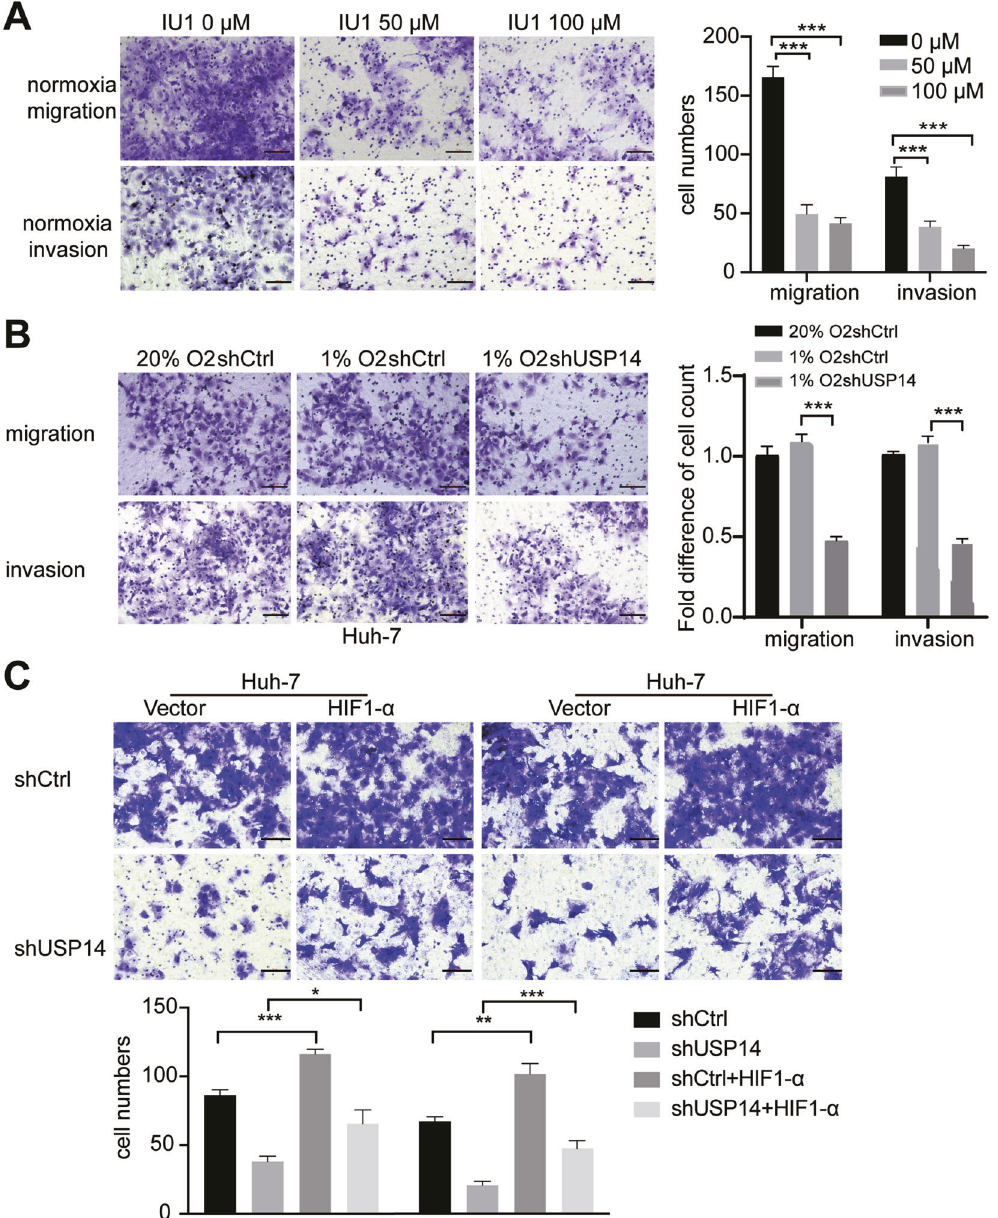
Fig. 5 USP14 promotes cell migration and invasion in HCC cells. A The migration and invasion ability of HCC cells were inhibited by 1U1 at a dose-dependent manner under normoxic conditions. Scale bar, 100 μ M. Quanti fi cation of the numbers of migration and invasion cells is shown as histograms on the right. In the histogram, the bars represent the mean ± SD ( n = 3), * P < 0.05, ** P < 0.01, *** P < 0.001. B USP14 depletion decreases the migration and invasion ability of HCC cells in hypoxia. Hypoxia groups were incubated in 1%O 2 /5%CO 2 /balance N 2 . Scale bar, 100 μ M. Data are shown as mean ± SD ( n = 3), * P < 0.05, ** P < 0.01, *** P < 0.001. C HIF1- α attenuated the migration and invasion inhibition induced by USP14 knockdown in Huh-7 cells. Scale bar, 100 μ M. * P < 0.05; ** P < 0.01; *** P < 0.001; **** P < 0.0001; ns = no signi fi